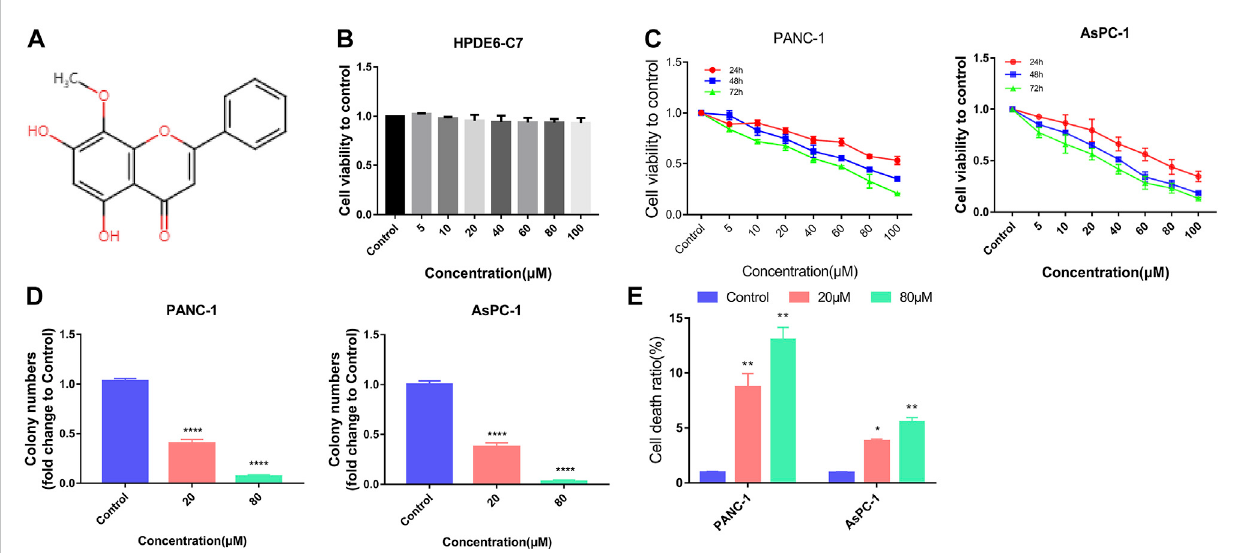
FIGURE 1 Wogonin inhibited viability and induced death in pancreatic cancer cells. (A) Chemical structure of wogonin. (B) CCK8 assay proved that treatment withwogoninfor 48 hhadlittletoxiceffect onhuman pancreaticductepithelialcellline (HPDE6-C7). (C) CCK8assayshowed thatwogonininhibitedthe viabilities of PANC-1 and AsPC-1 pancreatic cancer cells in a dosage- and time-dependent manner. (D) Colony formation assay proved that 20 μ M wogonincouldobviouslyinhibitPANC-1andAsPC-1pancreaticcancercellstoformcolonies,whichbecamemoreapparentwhenwogonindosage wasincreasedto80 μ M. (E) LDHreleaseassaydemonstratedthatwogonintriggereddosage-dependentlypancreaticcancercelldeath.*: p < 0.05versus control group, **: p < 0.01 versus control group. ****: p < 0.0001 versus control